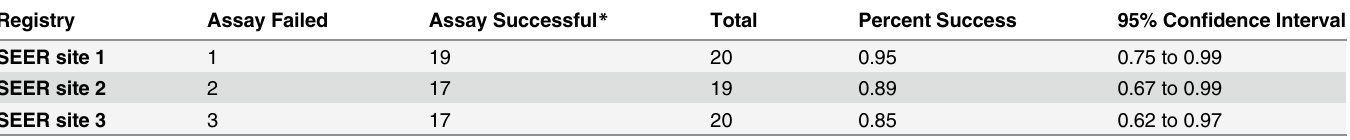
Table 6. Success of whole exome assays by SEER Registry